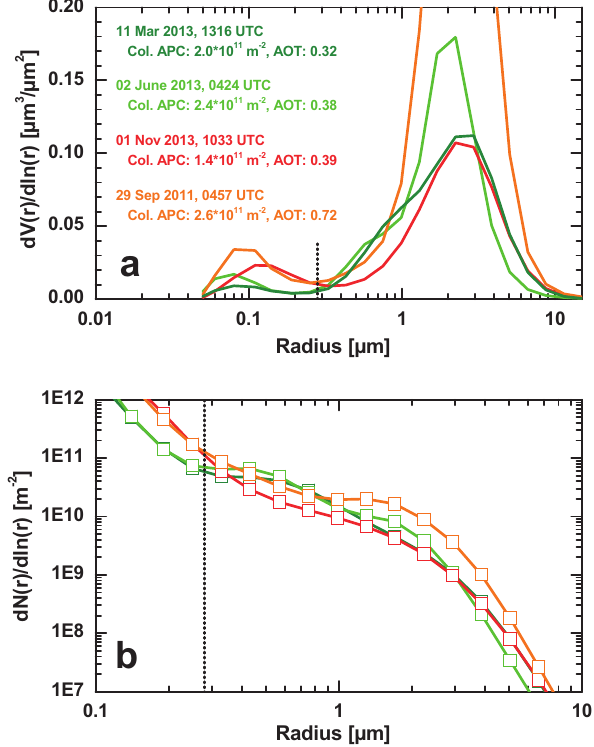
Figure 3. Column-integrated particle volume size distribution Fig. 3. Column-integrated particle volume size distribution (a) (a) and respective particle number size distribution (b) derived from AERONET sun/sky photometer observations at Limassol, Cyprus. and respective particle number size distribution (b) derived from Two Saharan dust cases (11 March 2013, olive, 2 June 2013, green) AERONET sun/sky photometer observations at Limassol, Cyprus. and two Middle East desert dust cases (29 September 2011, or- Two Saharan dust cases (11 March 2013, olive, 2 June 2013, green) ange, 1 November 2013, red) are shown. The dotted vertical lines and two Middle East desert dust cases (29 September 2011, orange, at 0.28µm indicate the lower limit of the particle radius range con- 1 November 2013, red) are shown. The dotted vertical lines at sidered in the calculation of column APC 280 , which is defined as 0.28 µ m indicate the lower limit of the particle radius range con- the sum of all particles larger than 280nm in radius. The column sidered in the calculation of column APC 280 , which is defined as APC 280 values for the four measurement cases are given as num- the sum of all particles larger than 280 nm in radius. The column bers together with 500nm total AOT in panel (a) APC 280 values for the four measurement cases are given as numbers together with 500 nm total AOT in the upper panel a.